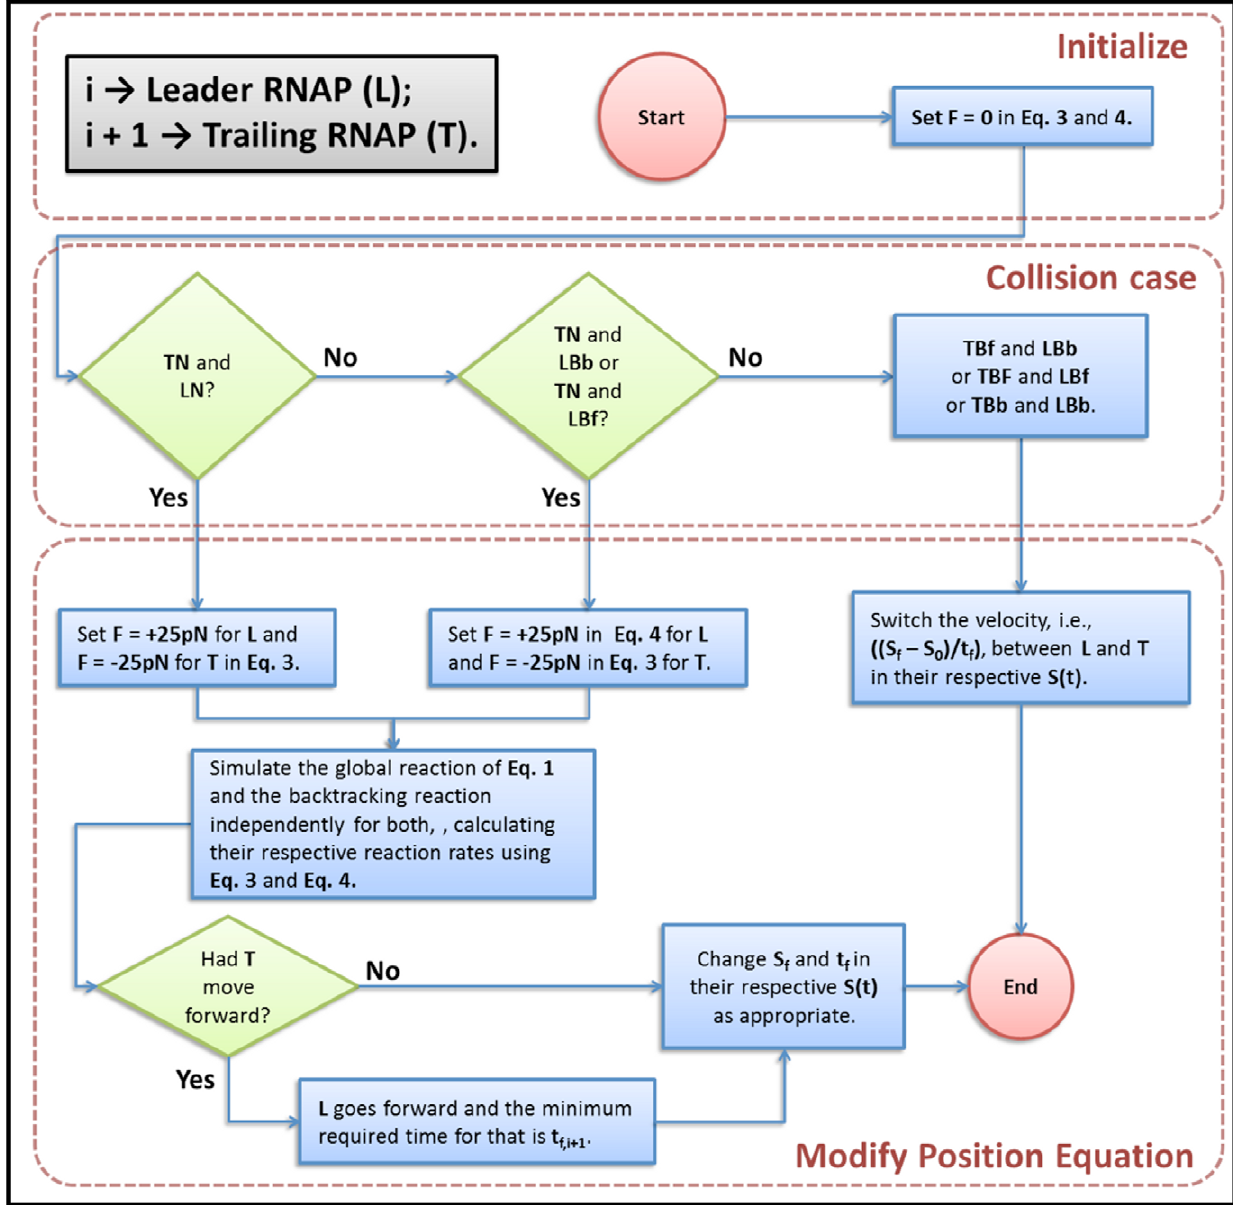
Figure 4. Diagram representing the subroutine to solve collisions: TN mean trailing RNAP in normal elongation. LN means leading RNAP in normal elongation. LBb means leading RNAP in backtracking backwards movement. LBf means leading RNAP in backtracking forwards movement. TBb means trailing RNAP in backtracking backwards movement. TBf means trailing RNAP in backtracking forwards movement.